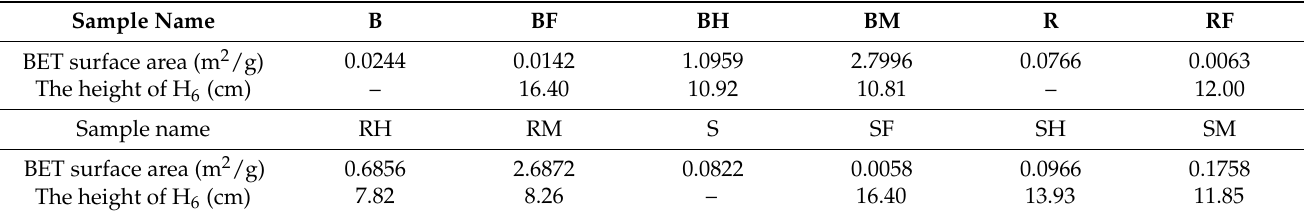
Table 5. The surface area of biochar and FW determined by BET and the final height of wheat plants based on